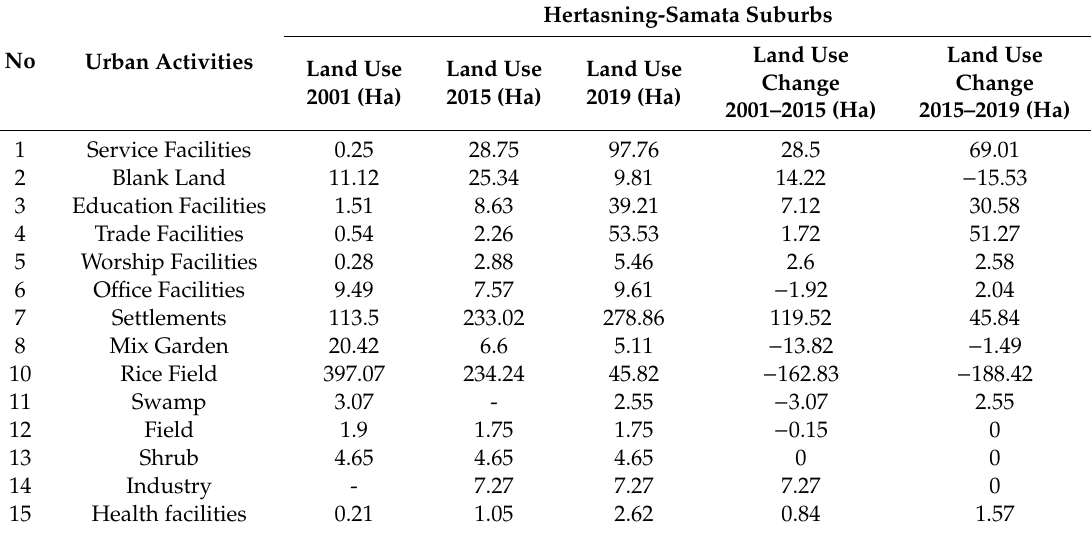
Figure 7. Change to Land Use in the Manggala Suburbs. Source: author elaboration, Map (c) 2001, 2015, 2019 Google.